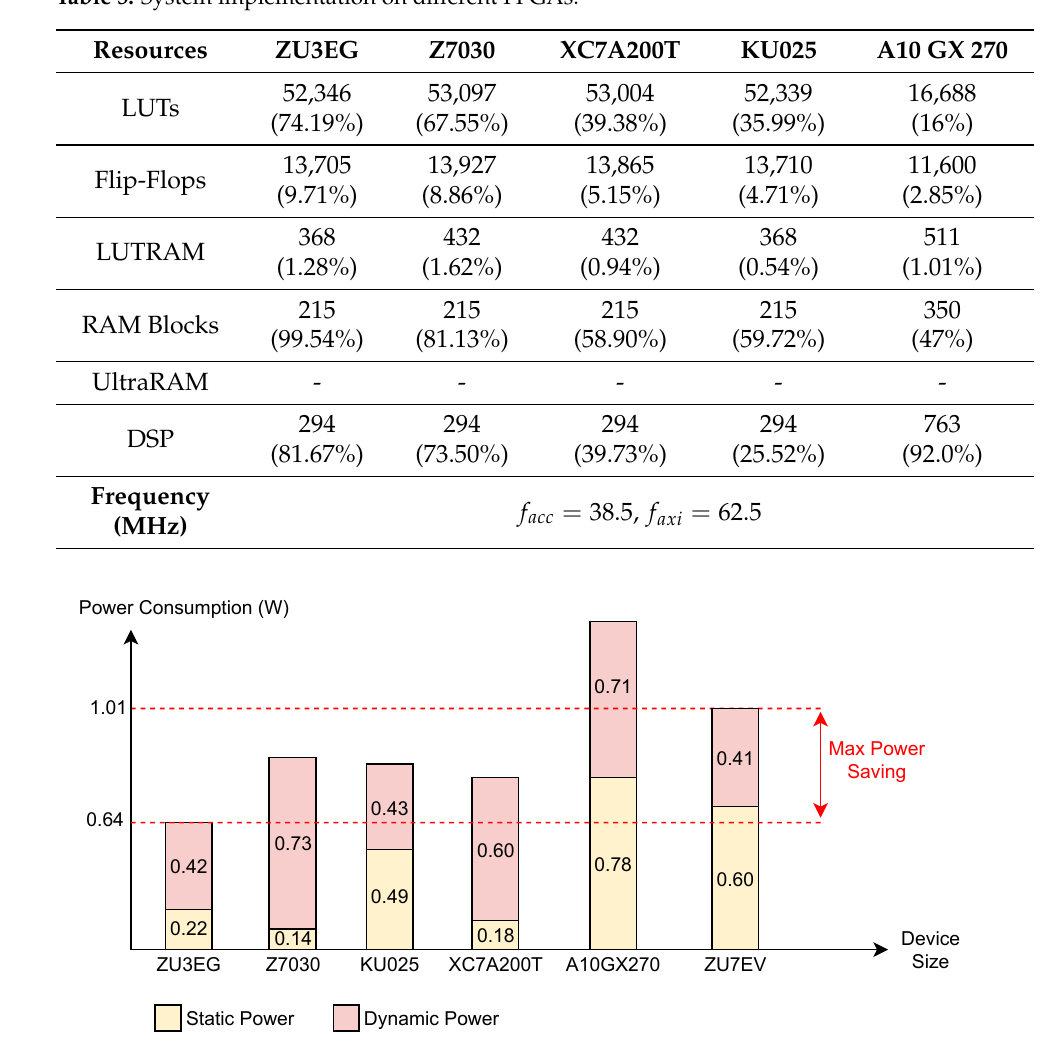
Figure 9. Accelerator power consumption on several